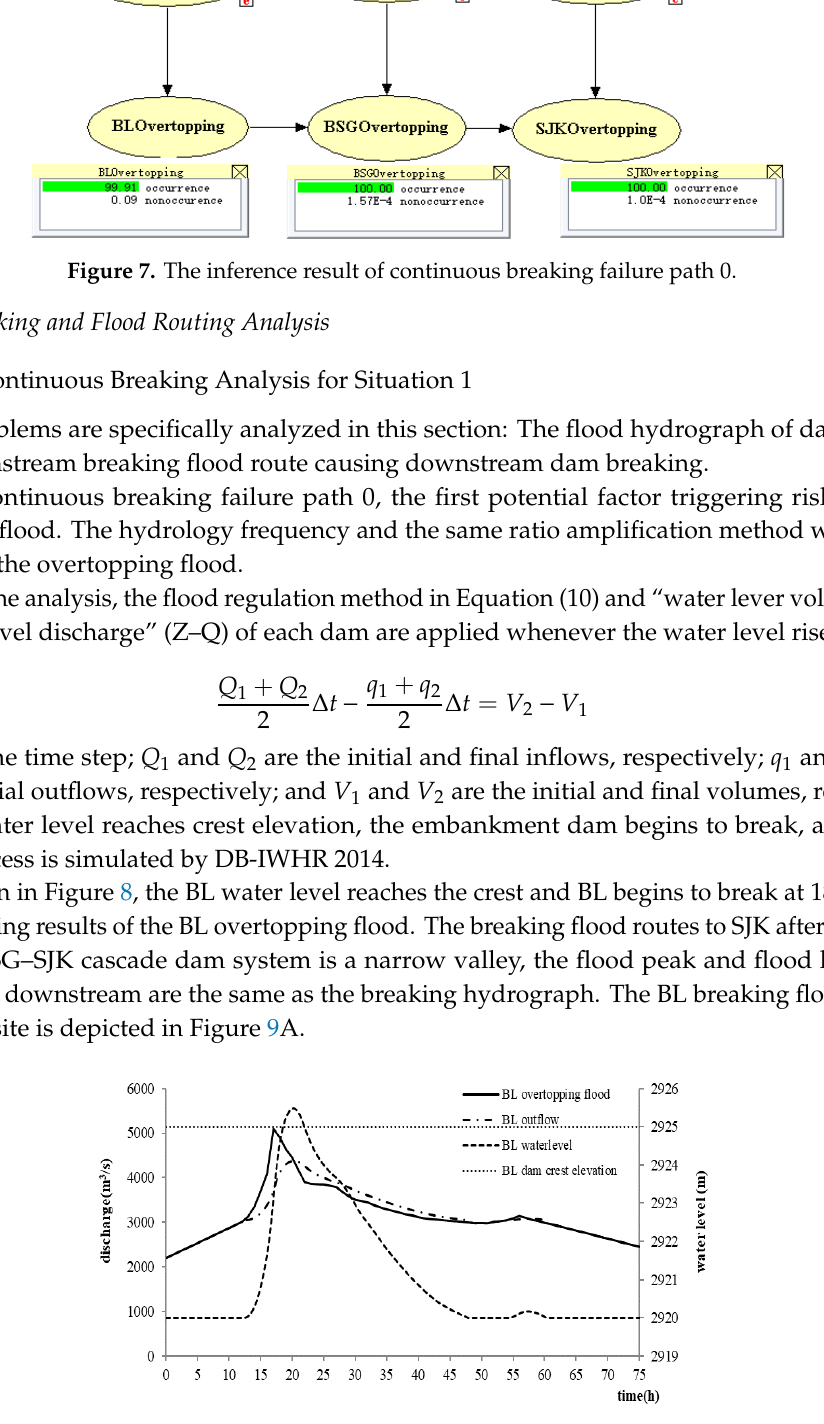
Table 9. The parameters for dam break analysis case.